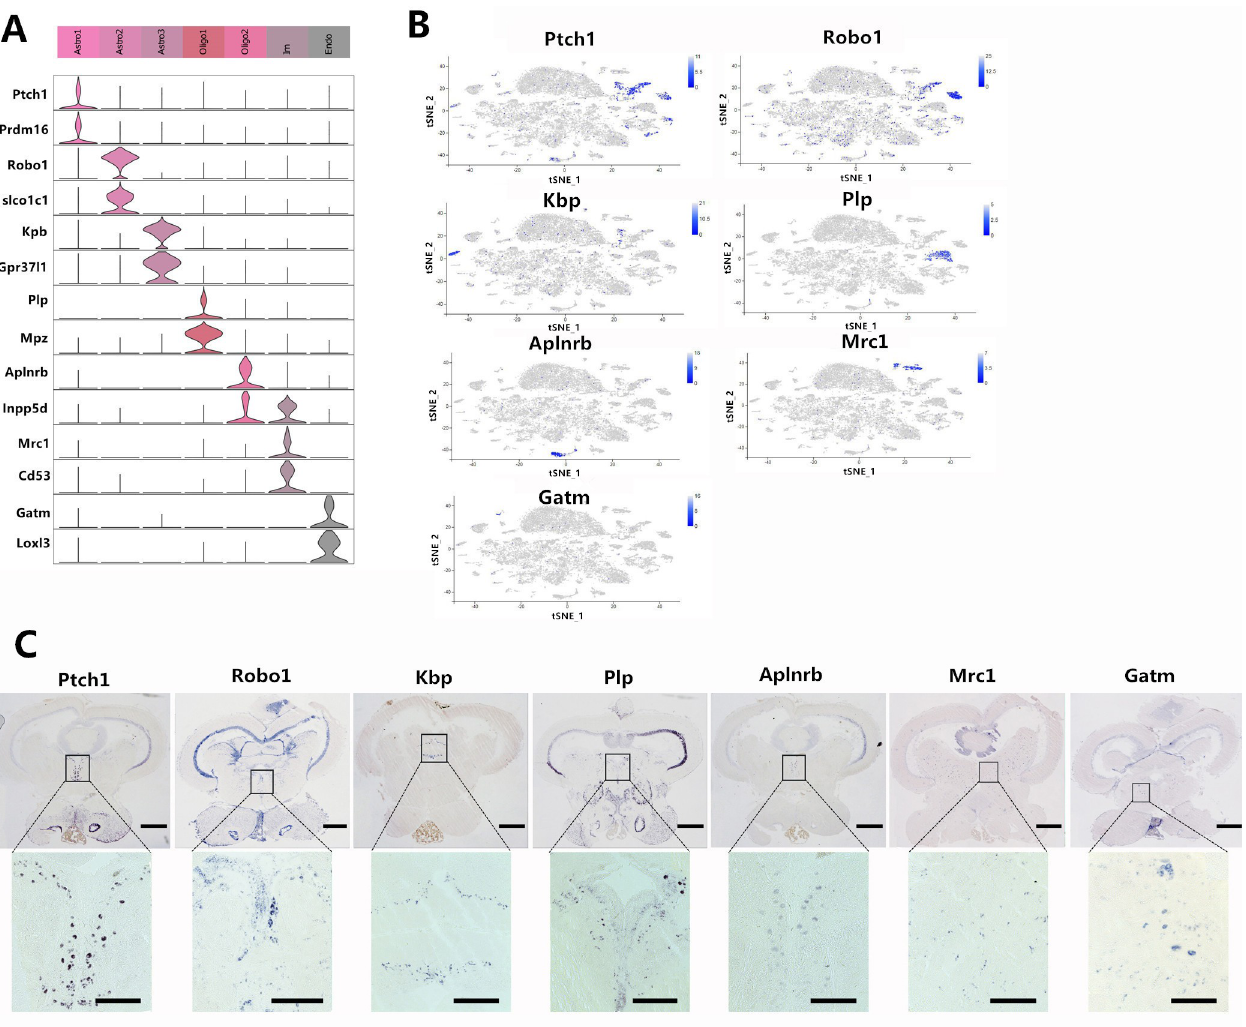
Fig 3. Overview of the non-neuronal cell clusters in the midbrain. (A) Violin plot showing the expression profile of representative marker genes in the seven non-neuronal cell clusters. Different clusters are color coded. Astro, astrocyte cell; Olige, oligodendrocyte cell; Im, immunology cell; Endo, endothelial cell. (B) The tSNE plots showing the expression of representative marker genes are restricted to specific non-neuronal clusters among all of the cells. The expression level is color coded. See also S3 Fig. (C) ISH data showing the expression of non-neuronal subtype markers Ptch1, Robo1, Kbp, Plp, Aplnrb, Fyb1, and Gatm in the midbrain. Above: the coronal sections of the entire midbrain region, Scale bar, 500 μ m. Below: enlarged images of the regions in black squares. Scale bar, 200 μ m.